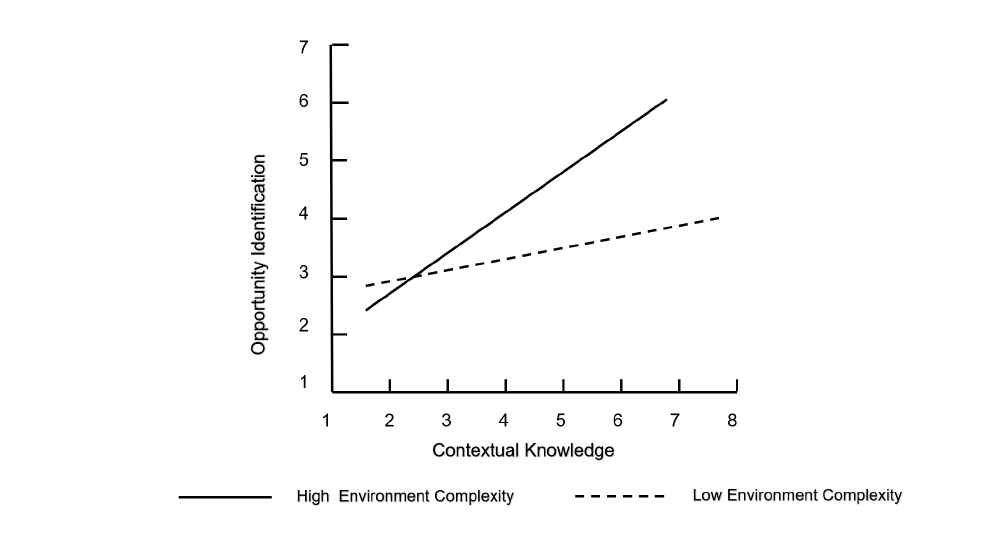
Fig. 3 The moderating role of environment complexity on the relationship between contextual knowledge and opportunity